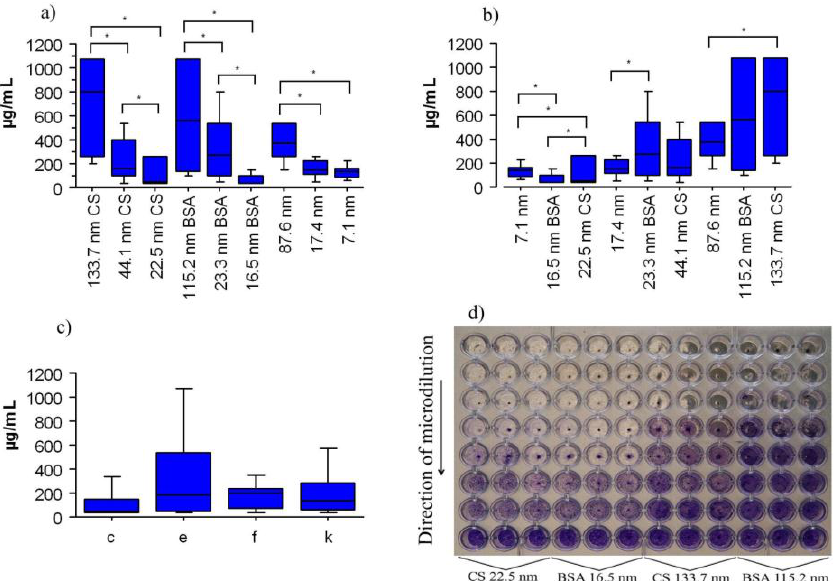
Figure 3. The antimicrobial activity of coated SNP against S. mutans in micrograms per milliliter ( µ g/mL). ( a ) SNP size; ( b ) coating type; ( c ) S. mutans serotypes; and ( d ) microdilution plaque (purple coloration shows stained bacteria). Values shown are the mean ˘ standard deviation. Clinical strains, 34 in number, ( c = 20; e = 6; f = 1 and k = 7) were assayed. Asterisks indicate significant differences ( p <